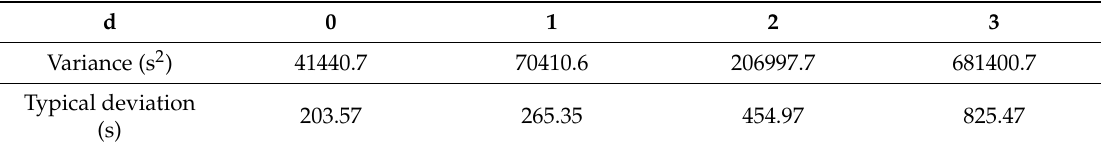
Table 1. Variance and standard deviation for different values of d .